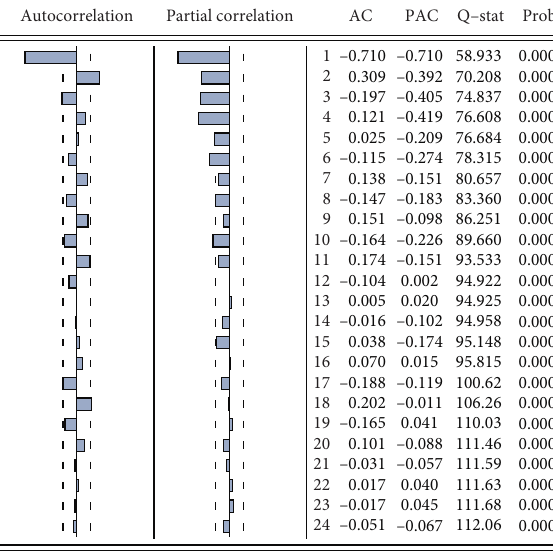
Figure 4: Autocorrelation of sequence d ′ x